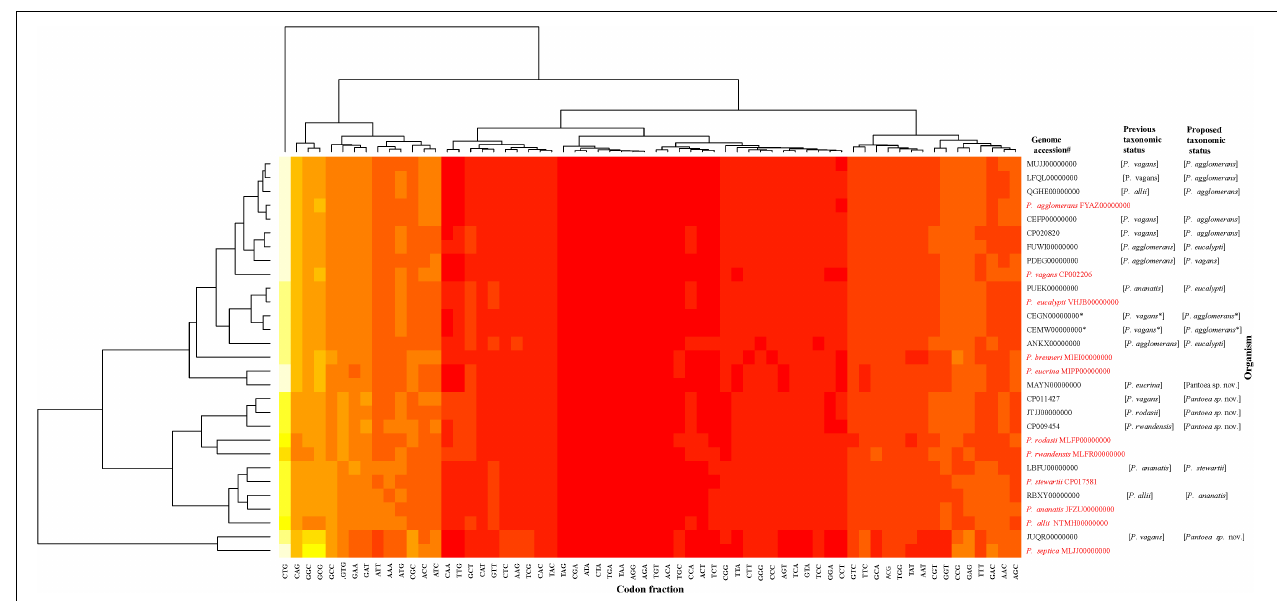
FIGURE 6 | Codon usage pattern analysis of the species-level misidentified genome sequences relative to the type strains (in red) of the previous and new proposed taxonomic status. Heatmap was generated using a BioPerl module as implemented in CMG-Biotools pipeline (Vesth et al., 2013). Colors indicate discrepancy in codon usage among strains from low (yellow, < 10%) to high occurrence (red, > 85%). CEGN00000000 and CEMW00000000 genomes denoted by asterisk ( ∗ ) have almost double the size of expected genome of a Pantoea species and as such did not cluster with the MLSA-predicted relative, P. agglomerans